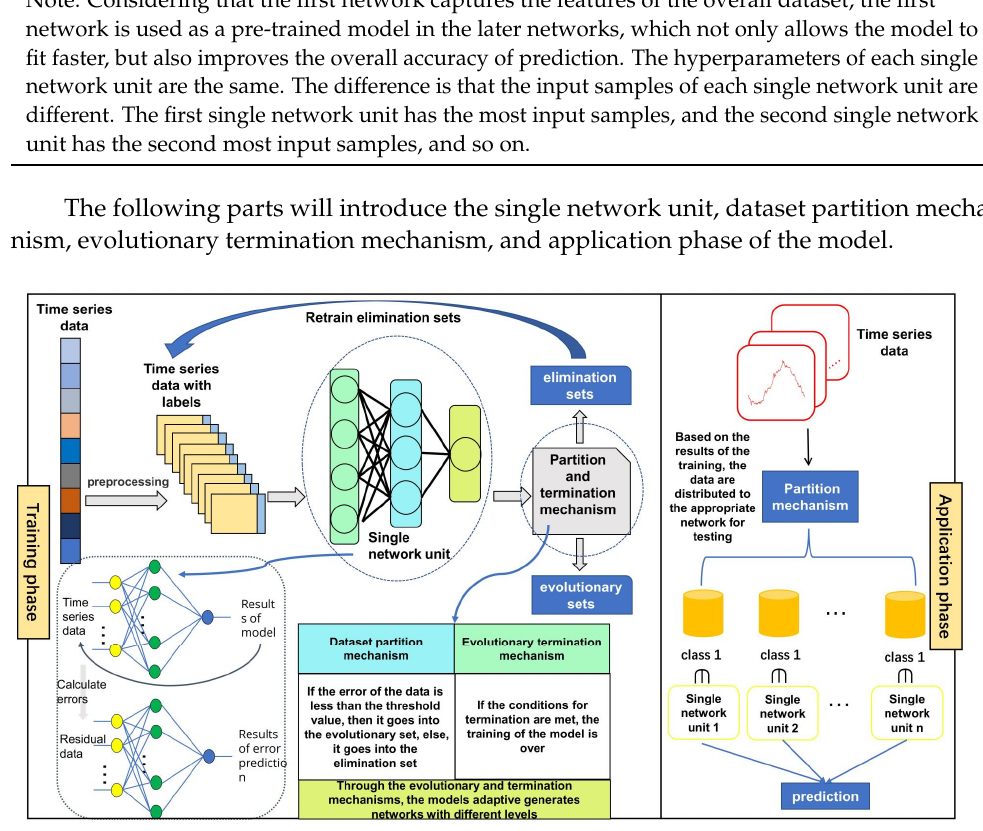
Figure 1. Structure of the CENS model.